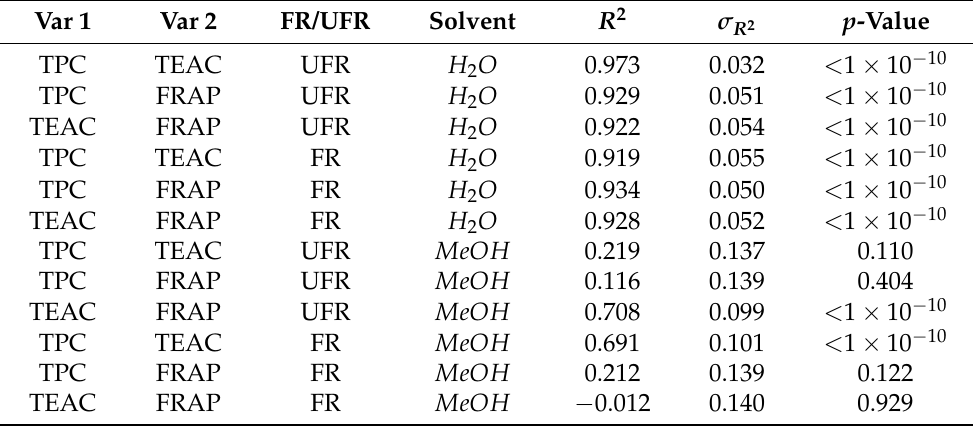
Figure 9. Scatter diagram for TEAC versus FRAP using water (left) and methanol for 51 FR samples (blue) and 47 UFR samples (orange). Table 1. Factor correlation estimates for FR and UFR samples for different